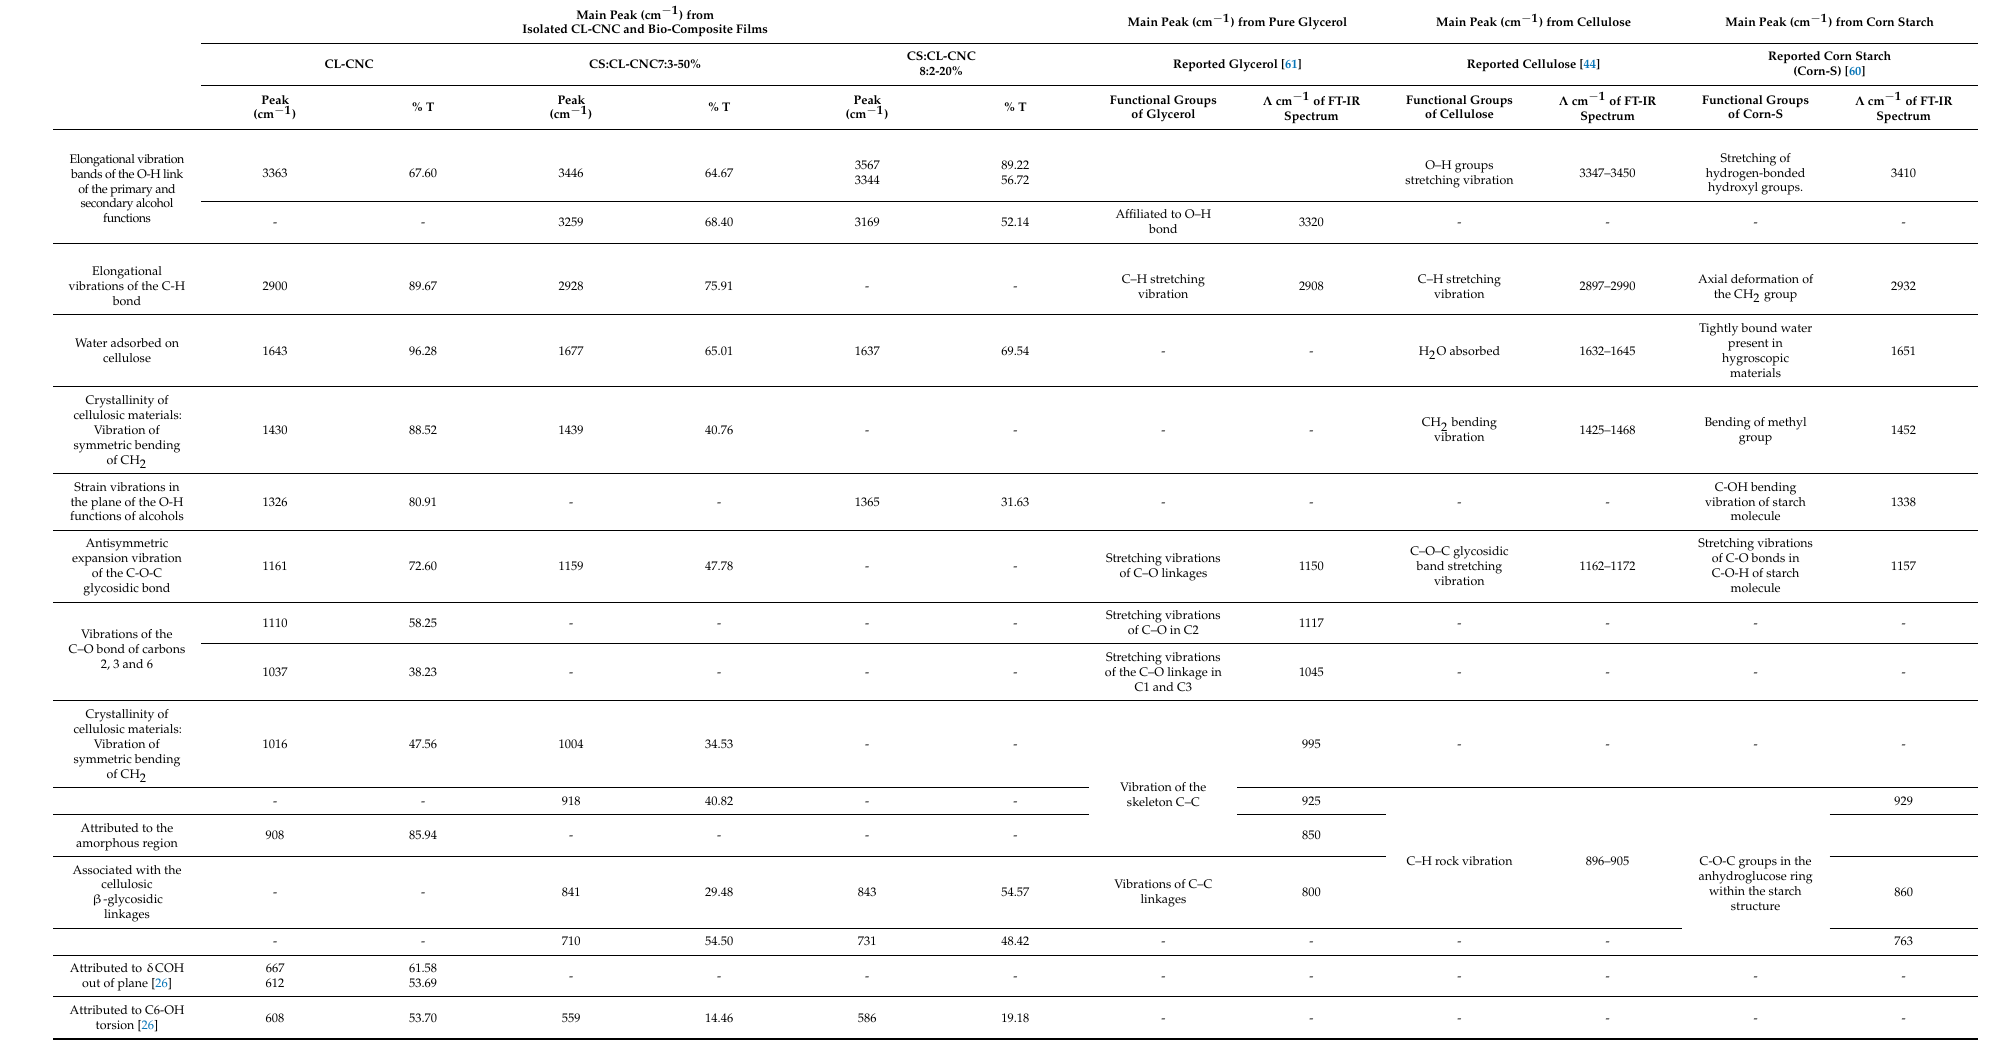
Table 2. Assignment of bands found in FTIR spectra of isolated CL-CNC, bio-composites films, reported pure glycerol, cellulose, and corn